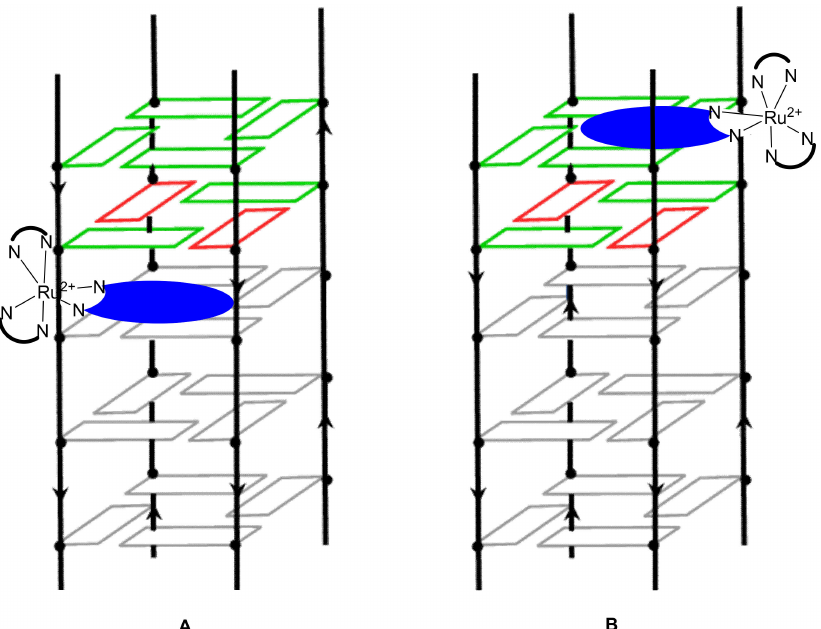
Figure 16. Binding interactions of ( A )— Λ -[Ru(TAP) 2 (11-CN-dppz] 2+ and ( B )— Λ -[Ru(phen) 2 (11-CN- dppz] 2+ with parallel tetramolecular G-quadruplex d(TAGGGTTA) using X-ray crystallography as proposed by McQuaid et al. [200] where adenine, guanine and thymine are colored in red, grey, and green, respectively and the 11-CN-dppz ligand is colored in blue.